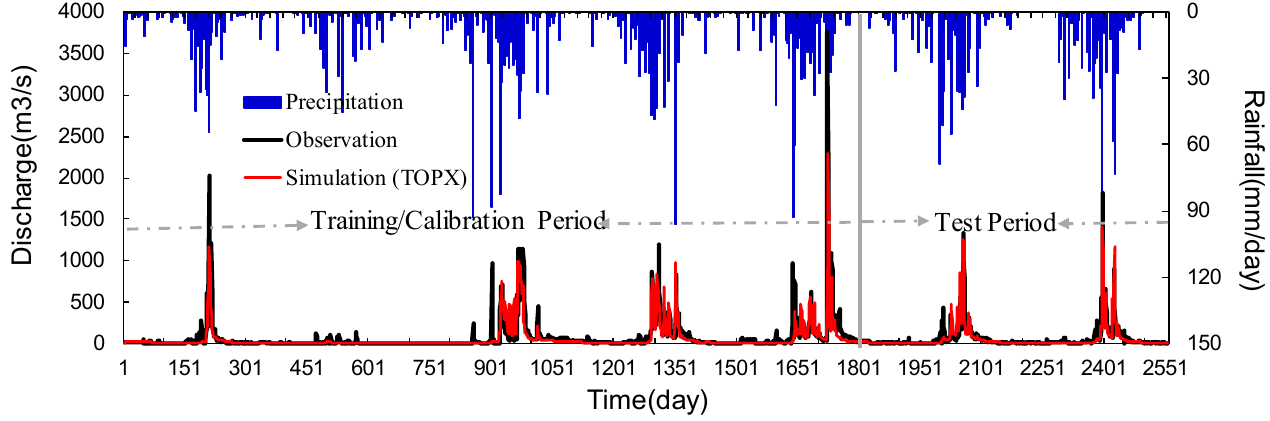
Figure 5. Runoff simulation results driven by TOPX models in the training or calibration period.